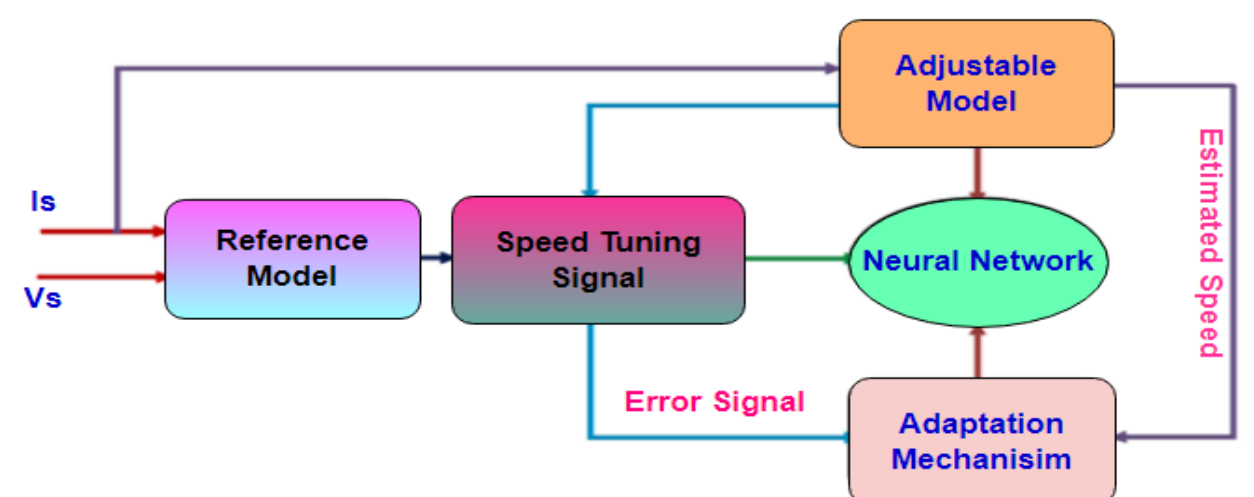
Figure 4. Proposed ANN ‐ based model reference adaptive system technique.